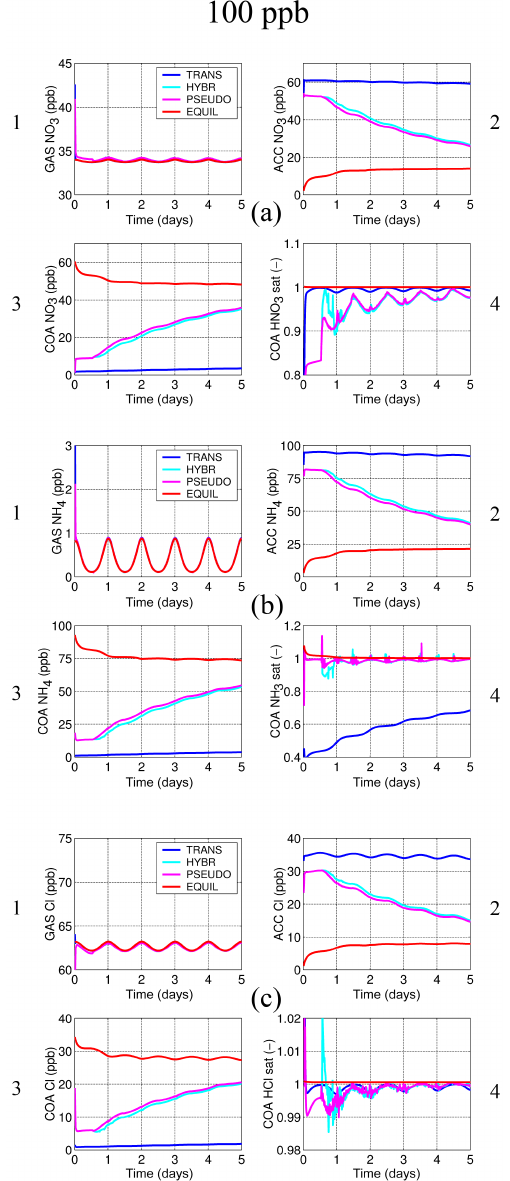
Figure 10. Same as Fig. 9 with initial mixing ratios of HNO 3 (g), NH 3 (g), and HCl(g) of 10ppb. Note that due to sea salt, total chloride is larger than 10ppb. HYBR is indistinguishable from PSEUDO due to almost similar values.